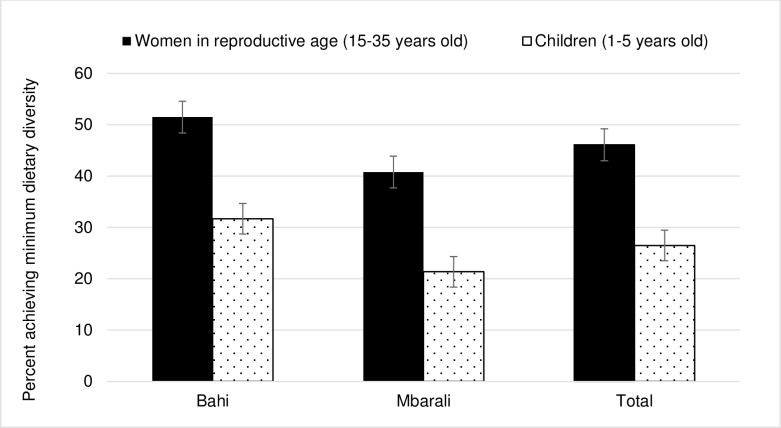
Percentage of women (15–35 years) and children (1–5 years) achieving minimum dietary diversity in 2015.